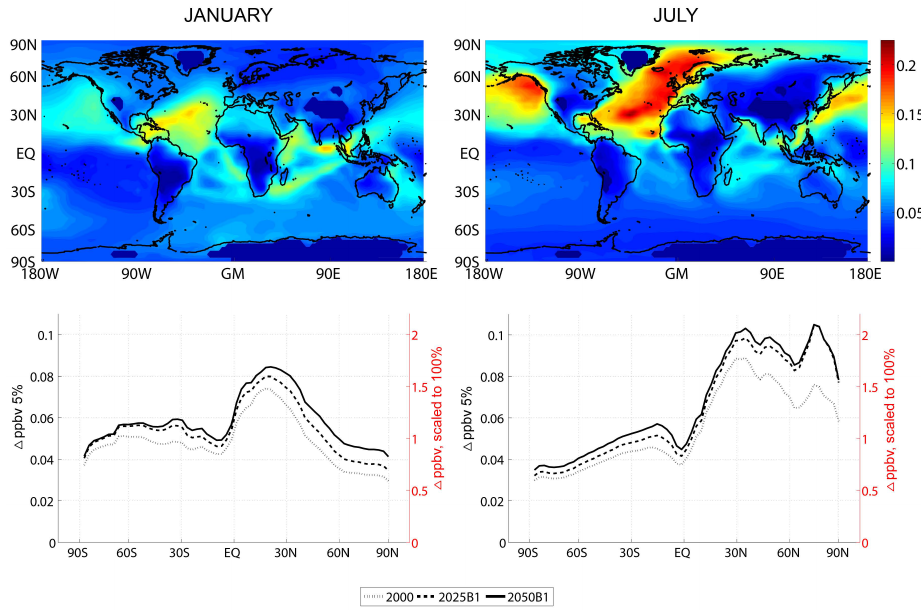
Fig. 8. Mean perturbations of ozone ( 1 ppbv) in the lower troposphere ( > 800hPa) during January (left) and July (right) for the 2050 B1 scenario (top) and as zonal means for all years (bottom). The color bar and the left y-axis show the impact caused by a 5% perturbation of ship emissions (simulations BASE – SHIP), while the red scales in the bottom figures are scaled up by a factor 20 from 5% to 100%.